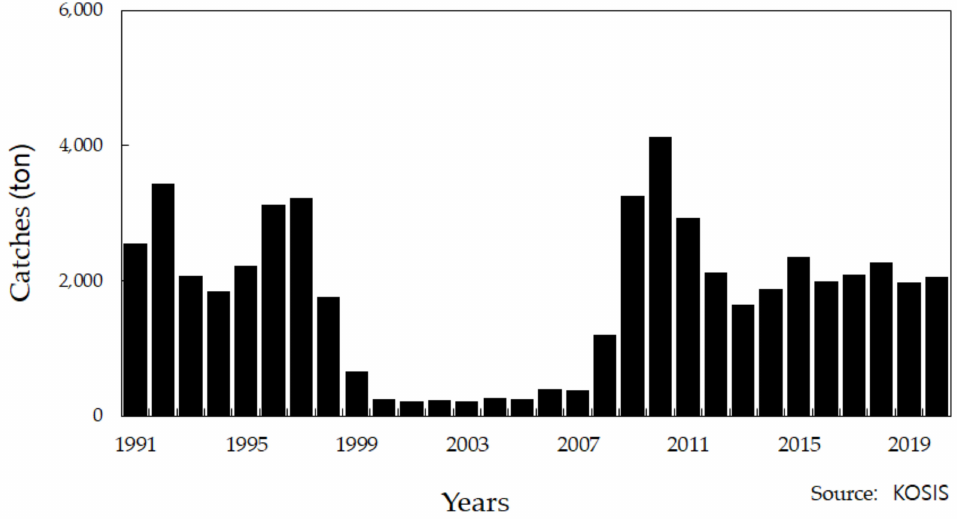
Figure 1. Annual catch in metric tons of ocellate spot skate Okamejei kenojei in Korea.